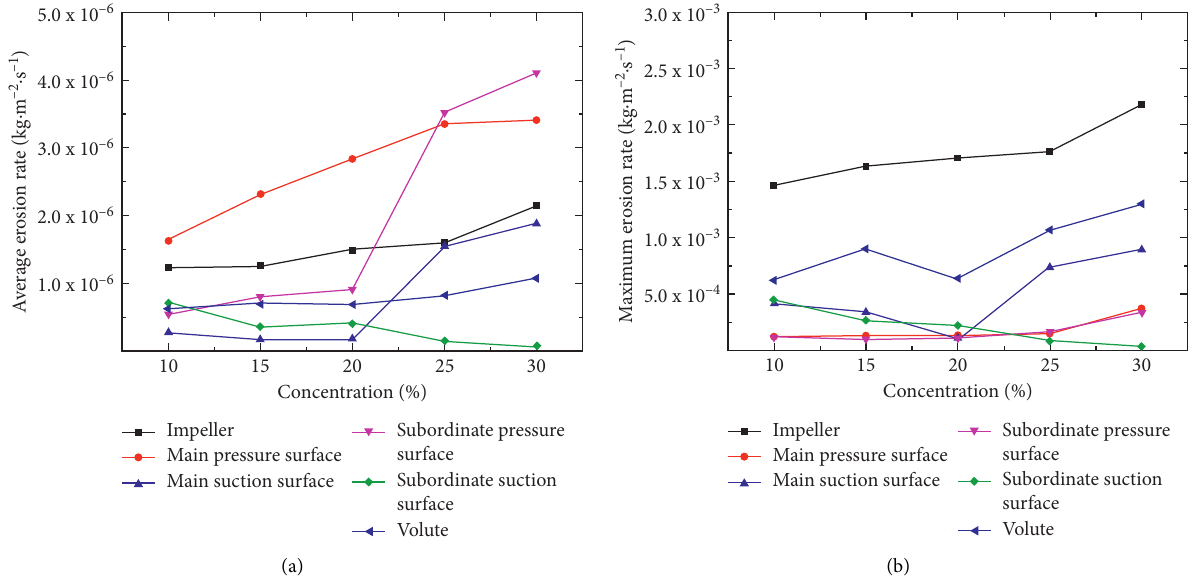
Figure 17: Comparison of wear rates of different parts at different particle volume concentrations. (a) Average wear rate; (b) maximum wear rate.